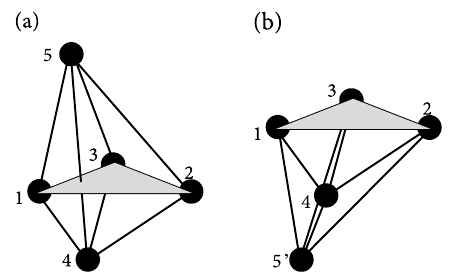
Fig. 2. Quintilateral (a), a version where node 5 has been mirrored at the base plane